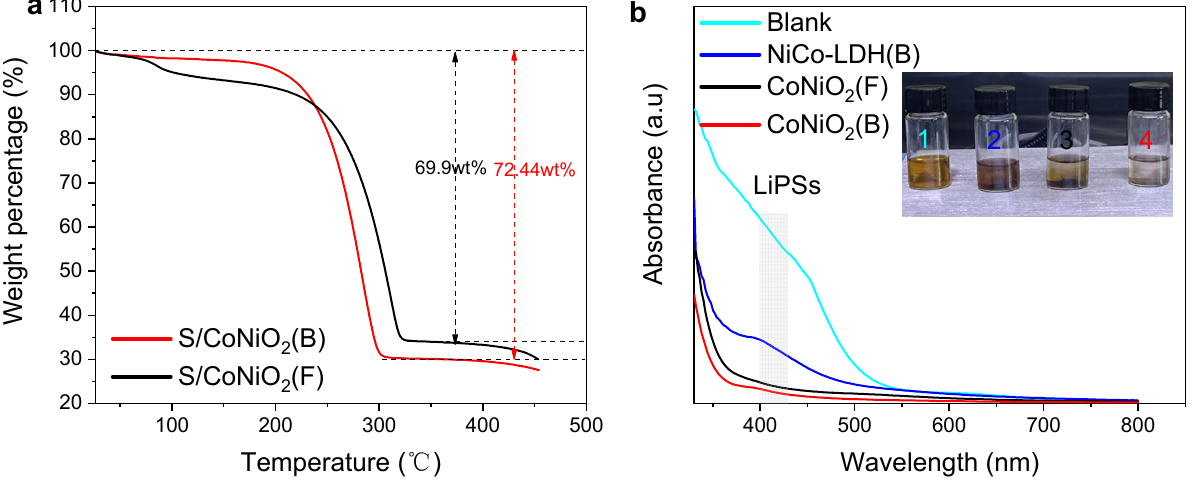
Figure 2. The result of XRD, Raman and BET; ( a ) X-ray diffraction pattern of NiCo-LDH(B). ( b ) XRD pattern of CoNiO 2 (B) and CoNiO 2 (F). ( c ) Raman spectra of CoNiO 2 (B) and CoNiO 2 (F). ( d ) XRD pattern of S/CoNiO 2 (B) and S/CoNiO 2 (F). ( e ) The isotherms of N 2 adsorption-desorption and ( f ) the distributions of pore sizes in CoNiO 2 (B) and CoNiO 2 (F). Sulfur is injected into the host by melt-diffusion, and the mass proportion of sulfur